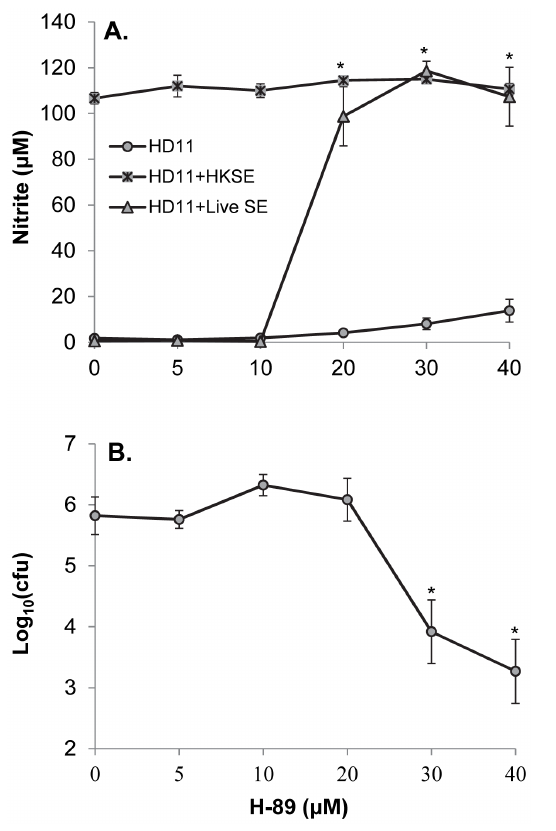
Figure 4. Effect of H-89 on S . Enteritidis growth in trypticase soy broth (TSB). A. The growth curves of S . Enteritidis in TSB containing various concentrations of H-89. An overnight culture of S . Enteritidis was diluted 1:20 in TSB medium containing various concentrations of H-89 and incubated at 41 u C in a 96-well optical plate. The optical densities at OD600 were measured at 2, 4, 8, and 24 h using a microplate reader to determine the growth of S . Enteritidis. B. The viable S . Enteritidis in culture containing various concentrations of H-89. At the beginning (2 hpi) and the end of incubation (24 hpi), viable S . Enteritidis [Log10 (cfu)] in each treatment were determined by plating serial 1:10 dilutions of the culture on the Difco’s xylose-lysine tergitol 4 (XLT4) agar plates and incubated at 41 u C for 24 h.